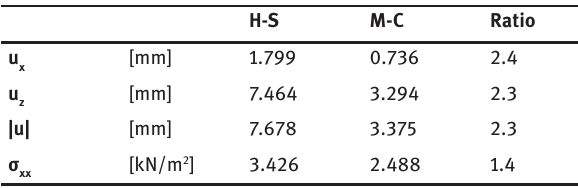
Table 5: Comparison between maximum values for M-C and H-S models (Case